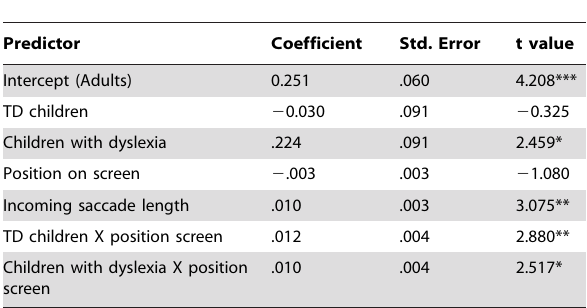
Table 3. Start of fixation disparity for all valid fixations during the reading experiment: coefficients and standard errors are shown and the t-value with significance